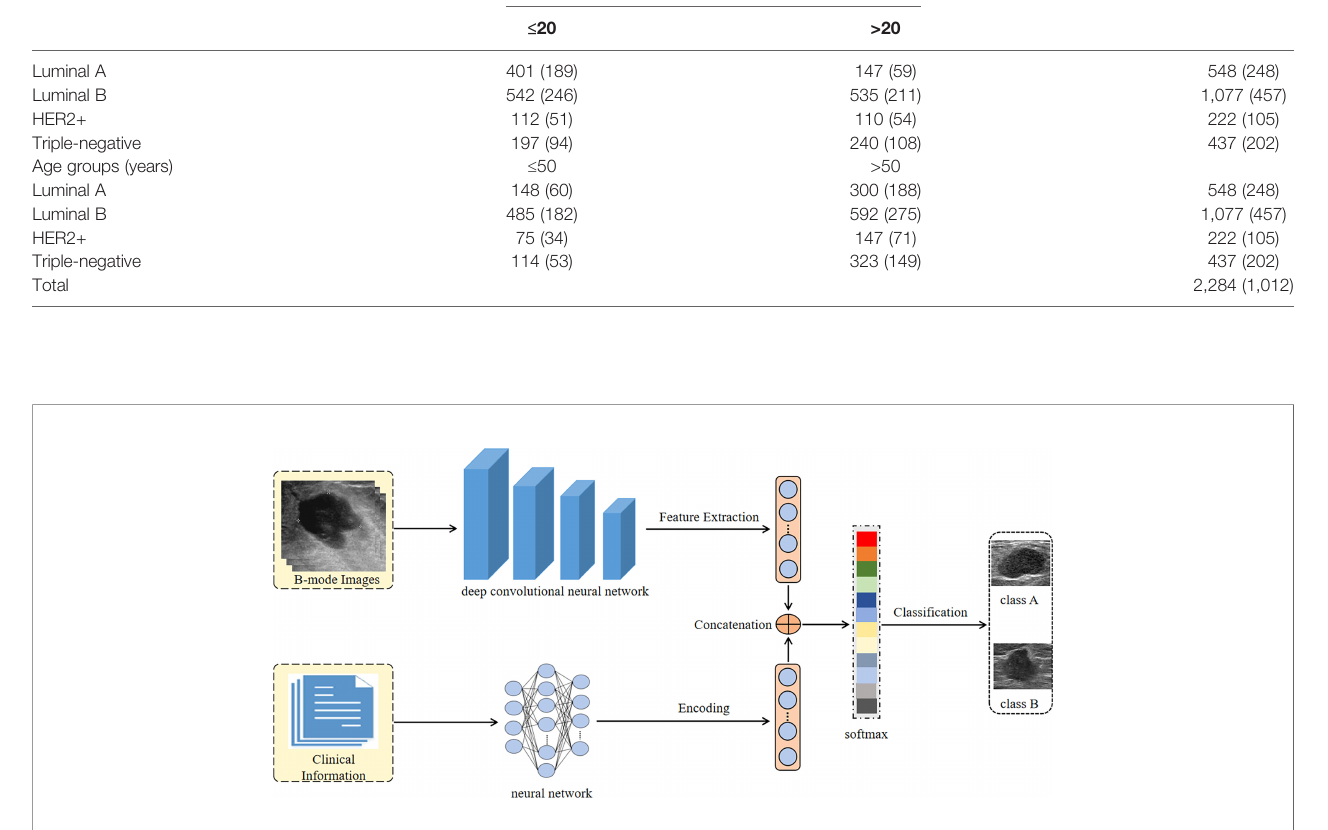
TABLE 1 | The main cohort dataset with different groups of tumor sizes and patient ages. Tumor size groups